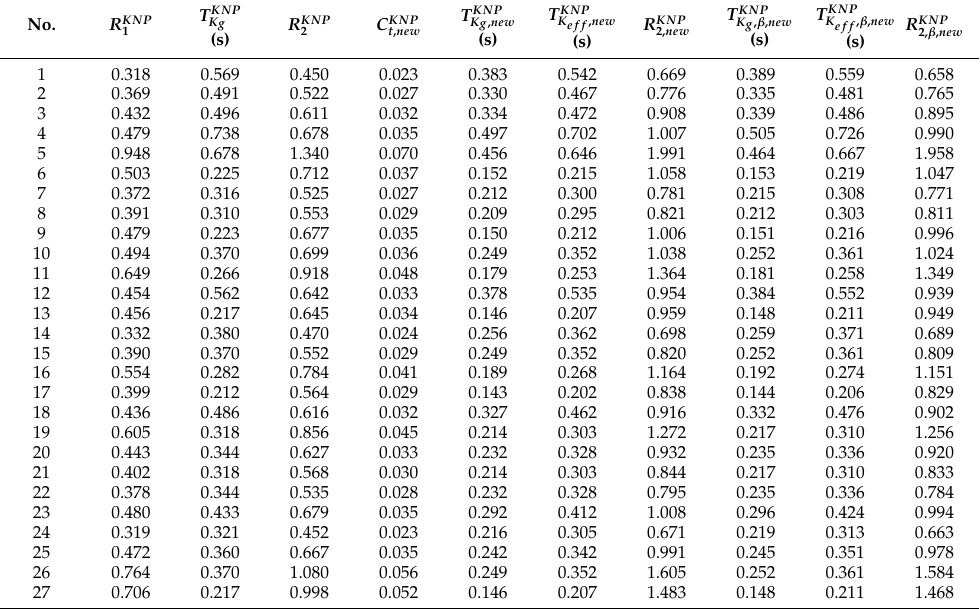
Table A3. Investigation on the C t value used for estimating the effective 1st period based on empirical relationship of KAN.EPE for the 27 RC